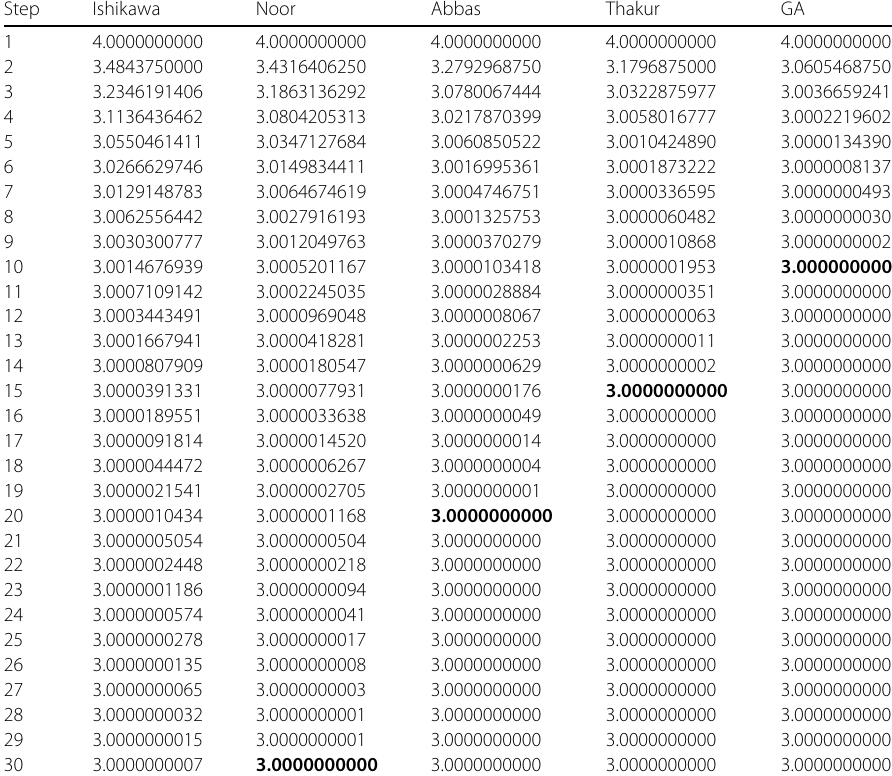
Table 2 Comparison of speed of convergence of the GA iterative method with Ishikawa, Noor, Abbas, and Thakur iterative